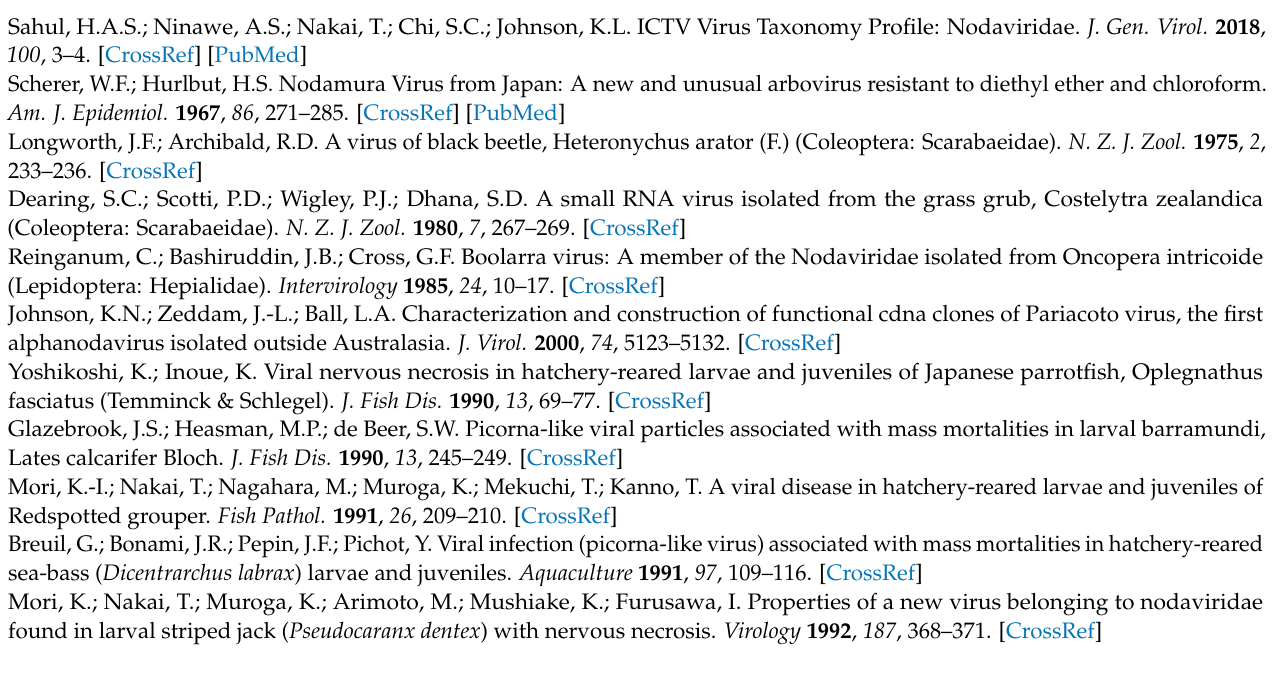
B2 proteins; Figure S2: Sequences of optimized RNLV1 ORF1a; Figure S3: Genome and encoded protein comparisons of RNLV1, RNLV2 and related virus representatives; Table S1: Primers used in this study; Table S2: Summary of conserved domain prediction of capsid proteins from RNLV1, RNLV2, and other related viruses; Table S3: Viruses used for protein homology and phylogenetic analyses; Table S4: Summary of